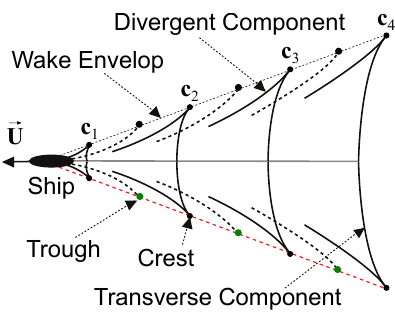
Figure 3. The Kelvin wake structure, indicating the transverse and divergent components as well as the crests and troughs of the wave